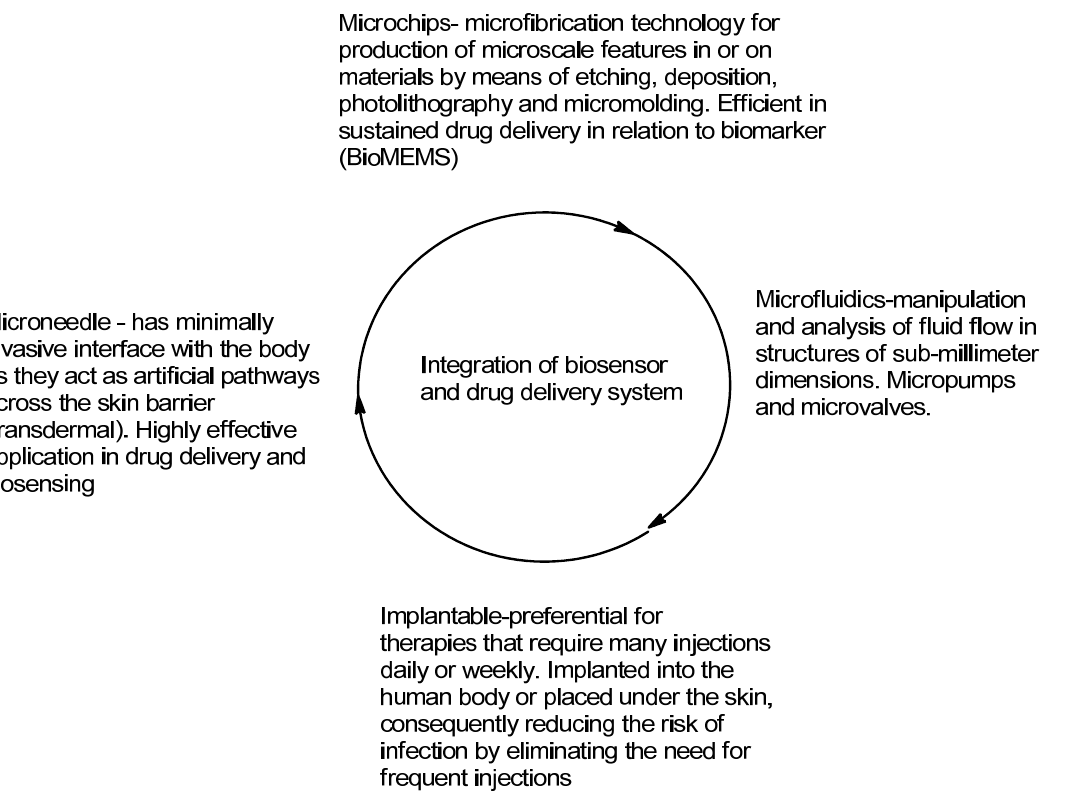
Figure 15. Technologies for integration of biosensors and drug delivery